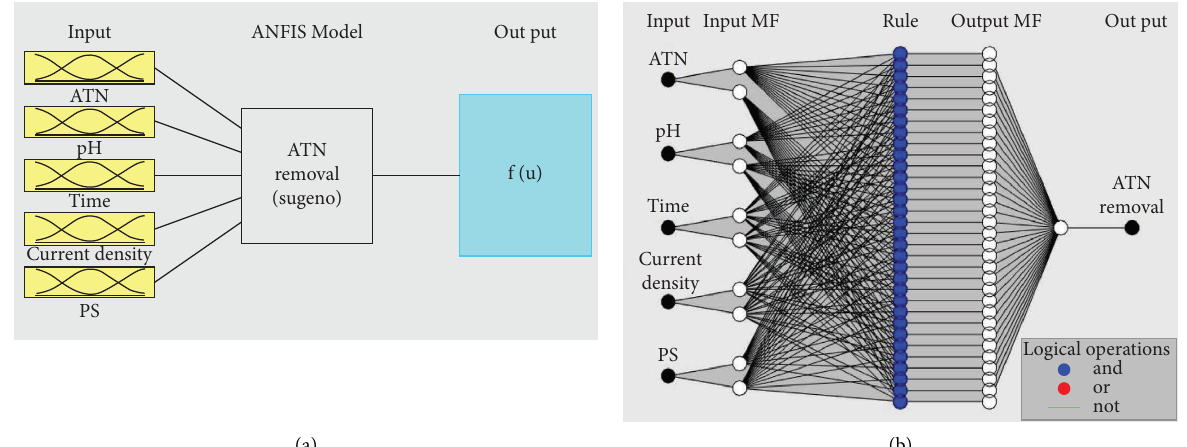
Figure 2: Developed (a) ANFIS structure. (b) Neural network model for ATN removal. –1–0.500.511.5 r rr o E